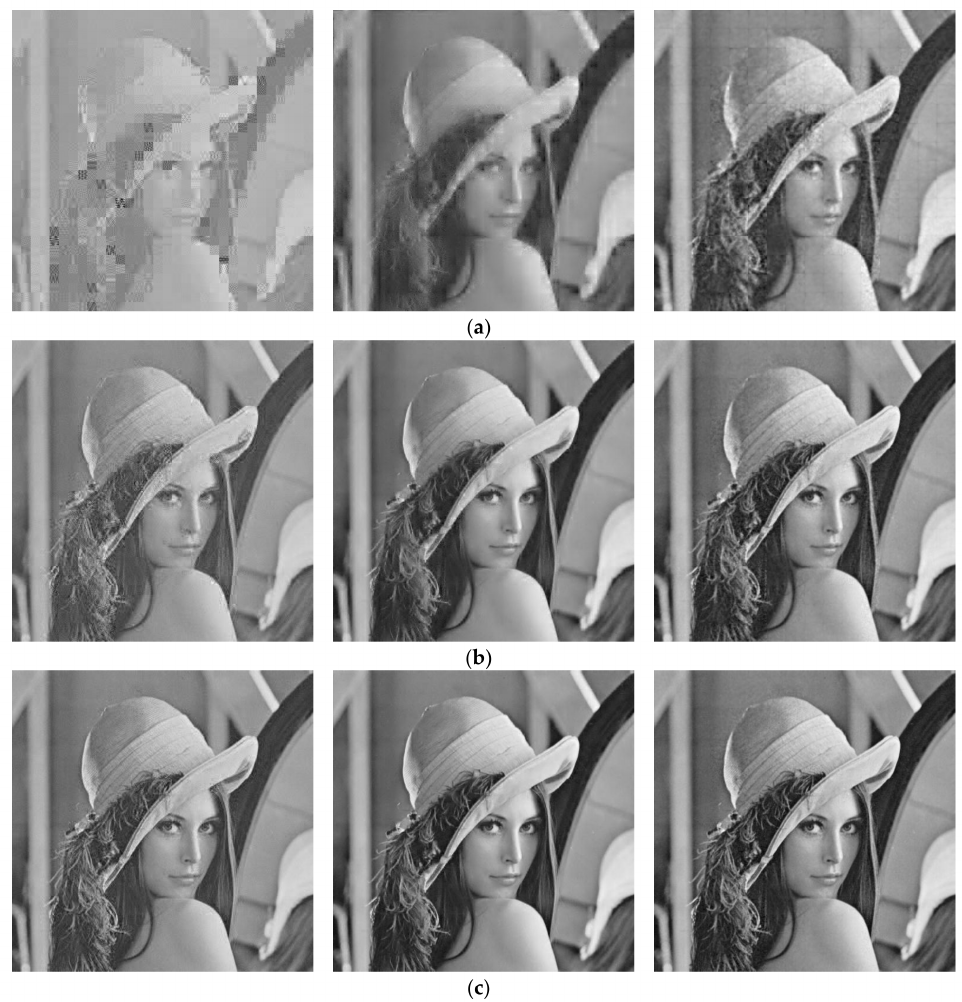
Figure 5. Comparison of subjective visual qualities of Lenna reconstructed by different recovery algorithms at S = 0.1, 0.3 and 0.5, respectively. From left to right: OMP, NESTA and the